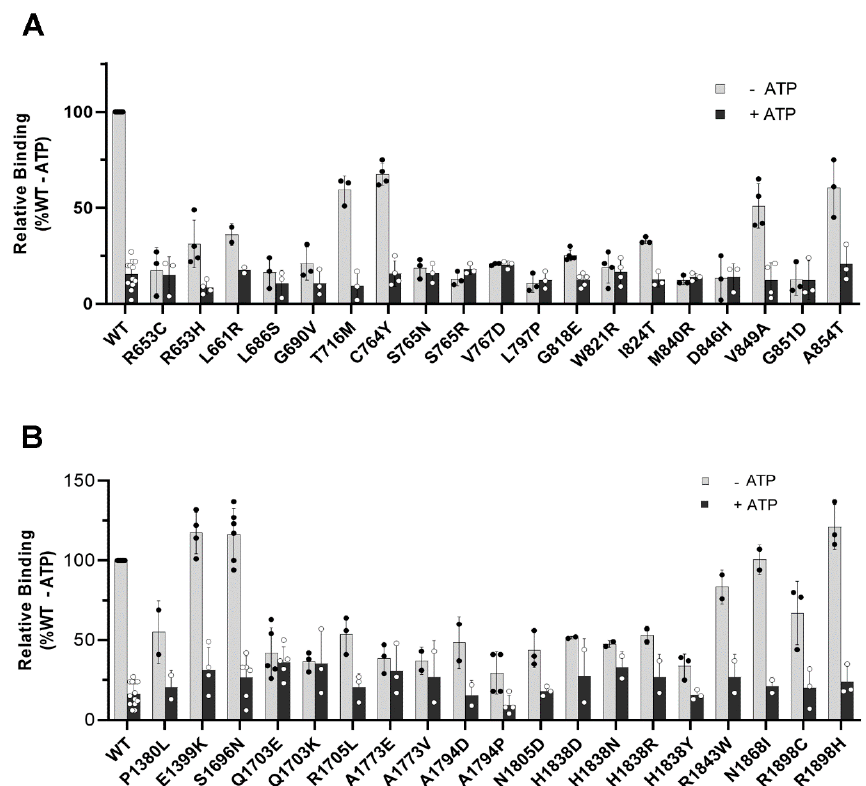
Figure 6. Binding of N -Ret-PE to TMD variants. ABCA4 TMD variants immobilized on an immunoaffinity matrix and containing bound N -Ret-PE were treated in the absence (grey) or presence (black) of 1 mM ATP. ( A ) N- Ret-PE binding profiles for TMD1 variants shown as a mean ± SD for n ≥ 3 and ( B ) TMD2 variants shown as a mean ± SD for n ≥ 2.